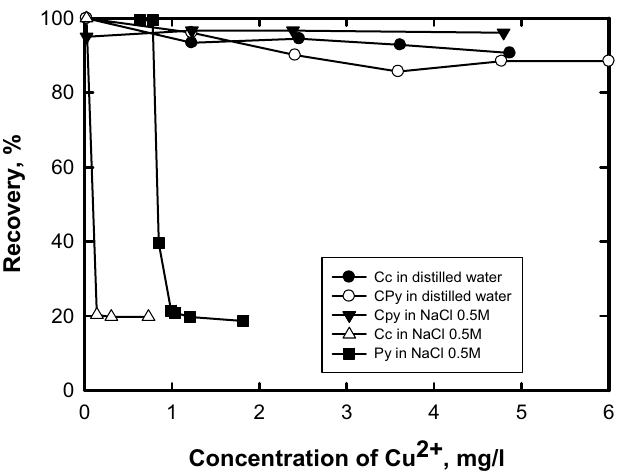
Concentration of Cu2+ , Fig. 10 Effect of Cu 2 + ions on the flotation of chalcocite, chalcopyrite and pyrite in distilled water and NaCl 0.5M solu- tions with IsopX and MIBC (for chalcopyrite α -terpineol was used as frother).